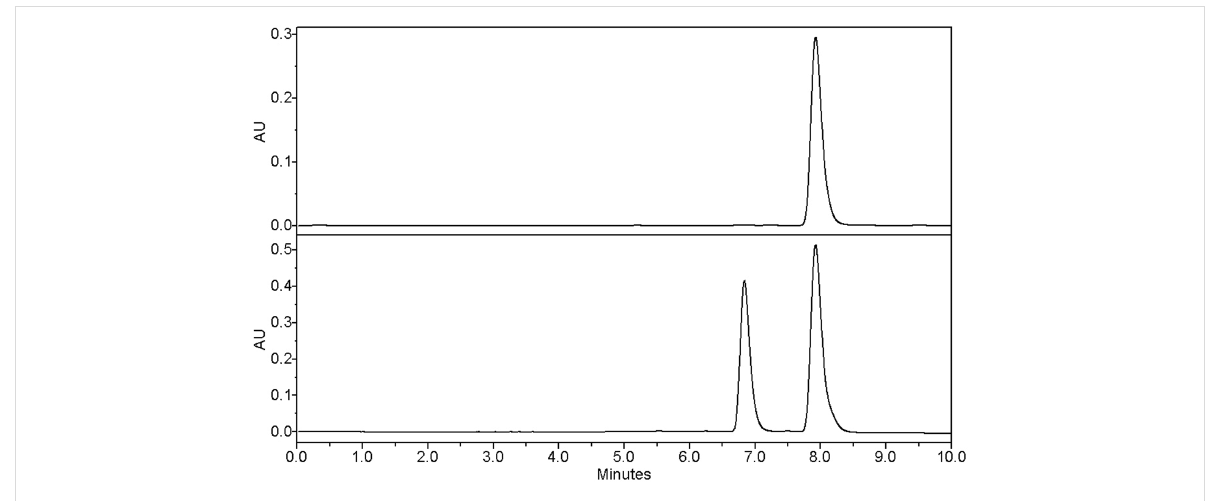
Figure 7: UV traces (254 nm) of the chiral HPLC for commercial ( S )- 3 (top) and the ( R / S )- 3 (bottom). t R = 6.84 min ( R ) and 7.93 min ( S ).